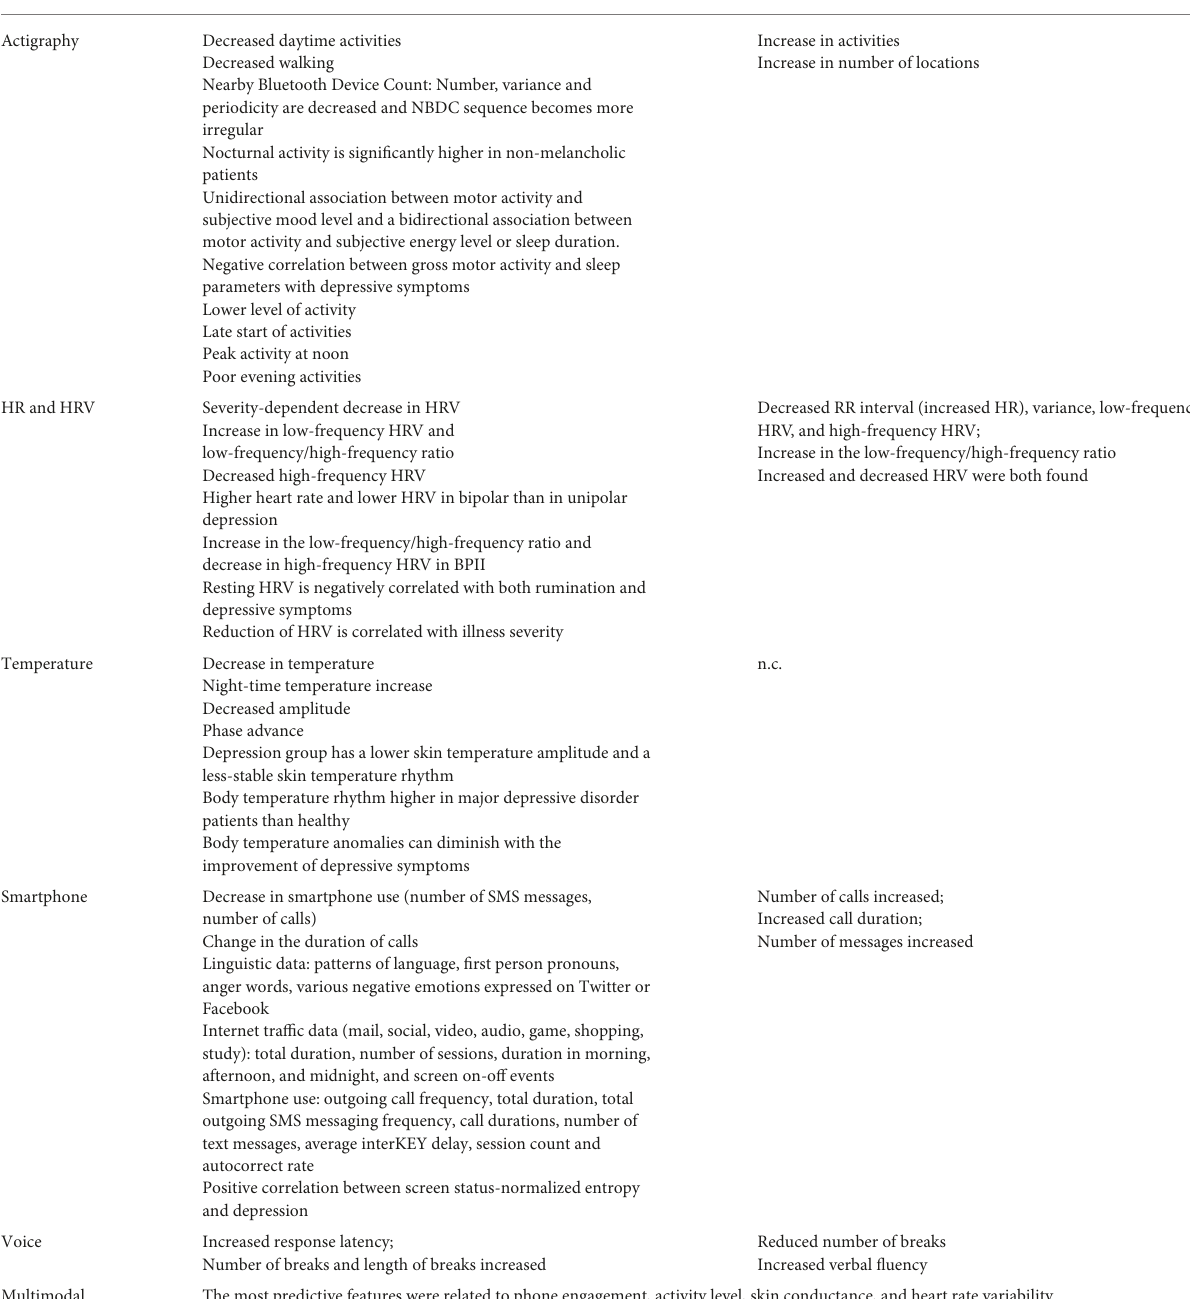
TABLE 3 Digital phenotype of features relevant to mood